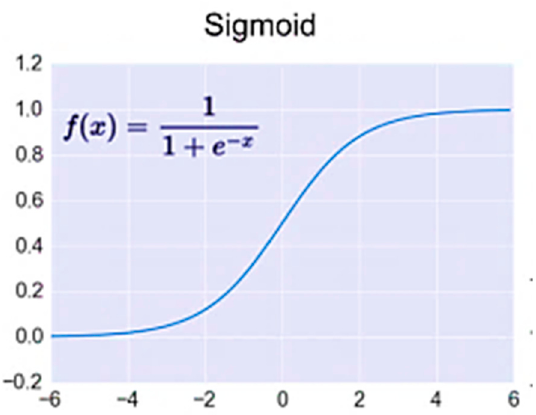
Figure 15. Activation function. Multiple input neurons have individual inputs P 1 , P 2 , P 3 .... P